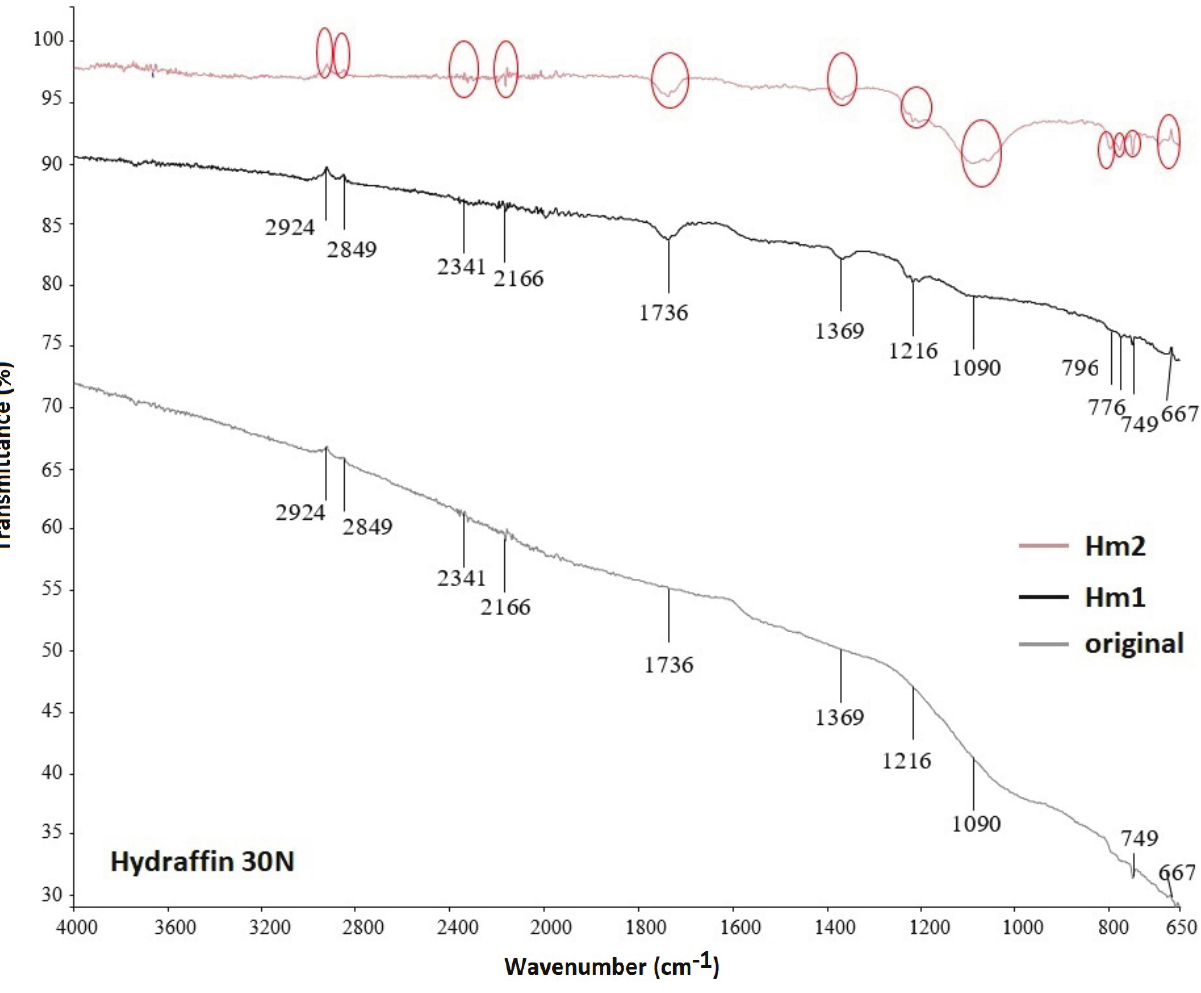
Fig. 2 – FTIR spectrum of activated carbon Hydraffin 30N in original, Hm1 and Hm2 tions already fixed for the adsorption process (ini - tial HA concentration 5 mg L –1 , solution pH 7.5, temperature 25 °C and 35 °C, and adsorption time 120 min, 120 rpm). Obtained results are present in Fig. 3. In theory, as the adsorbent’s dosage increases, so does the surface area and the number of active sites, which results in the increasing of HA percent - age removal. 21,24 As shown in Fig. 3, an increase in adsorbents dosages increased the rates of HA remov - al for all four tested adsorbents. The highest HA re - movals were obtained when dosage of 1 g/100 mL were used at 35 °C. Comparing the efficiencies of modifications, more efficient removal of HA were obtained with activated carbons modified according to Protocol 1. Adsorbent Cm1, at highest tested dose of 10 g L –1 , removed over 96 % of HA at 35 °C (Fig. 3a), while Hm1 (Fig. 3b) removed max 58.2 % of HA under the same experimental condi - tions. Amount of adsorbed HA per unit mass of ad - sorbent increased with dosages as the result of high - er total number of active adsorption sites, but